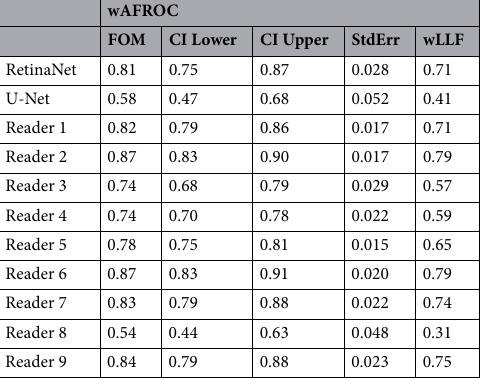
Table 2. Figure of merits (FOM), 95% confidence intervals (CI) and standard error (StdErr) for wAFROC metrics. The weighted lesion localization fraction (wLLF score) was retrieved at an x-axis 0.2 operating point for all readers and CNNs on the wAFROC curve.